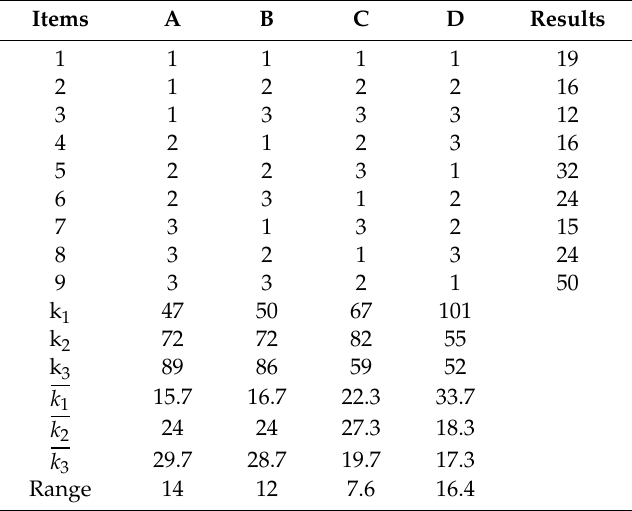
Table 4. Orthogonal experimental design and range analysis.